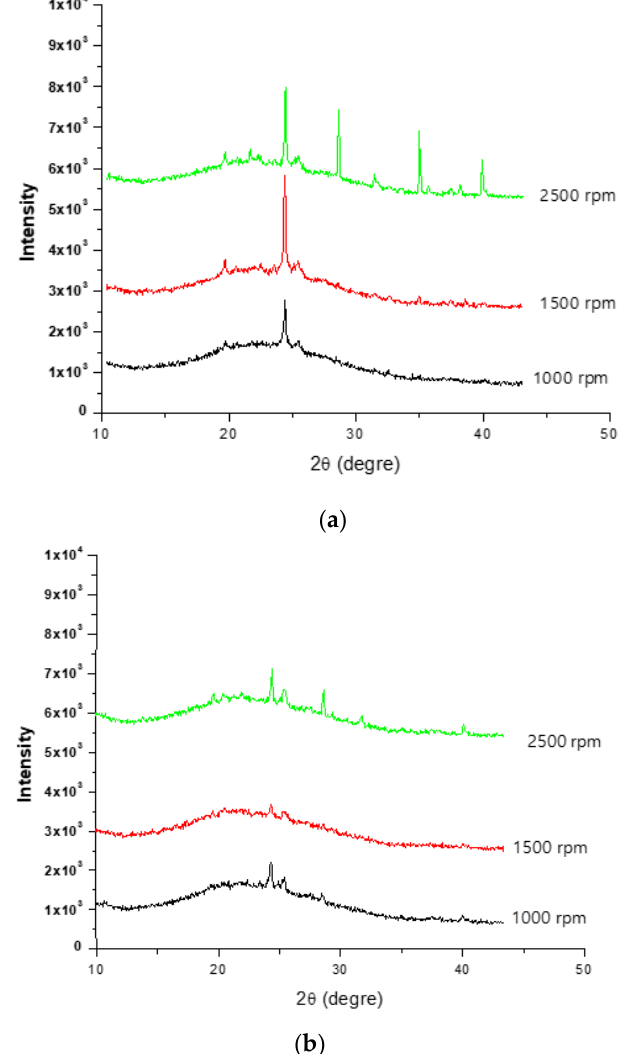
Figure 7. XRD spectra obtained using ( a ) 45 grid abrasive, and ( b ) 100 grid abrasive at different polishing speeds for white granite.